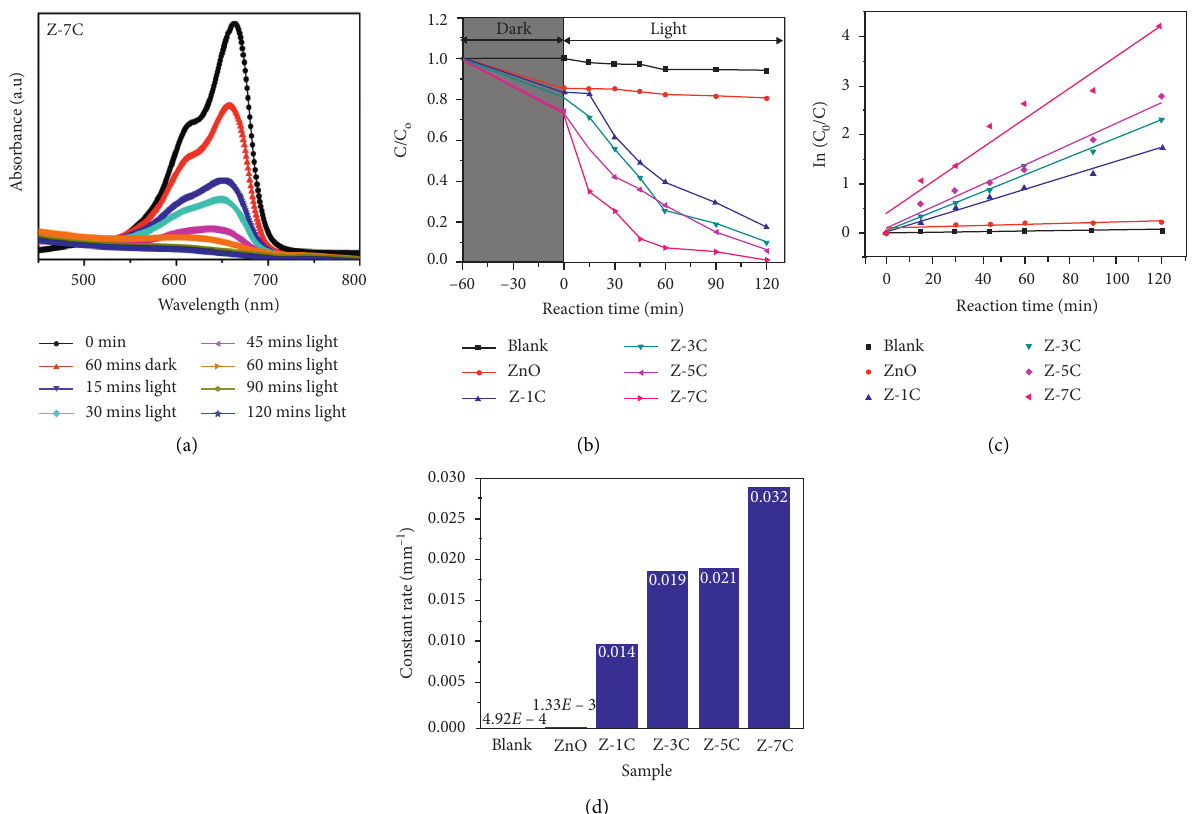
Figure 5: (a) Absorption spectra of Z-7C samples. (b) Photocatalytic degradation of MB under visible-light irradiation. (c) Determination of the constant rate ( k ) of the photocatalytic degradation of MB by kinetic linear simulation plots. (d) The constant rate ( k ) of the photocatalytic degradation of MB by